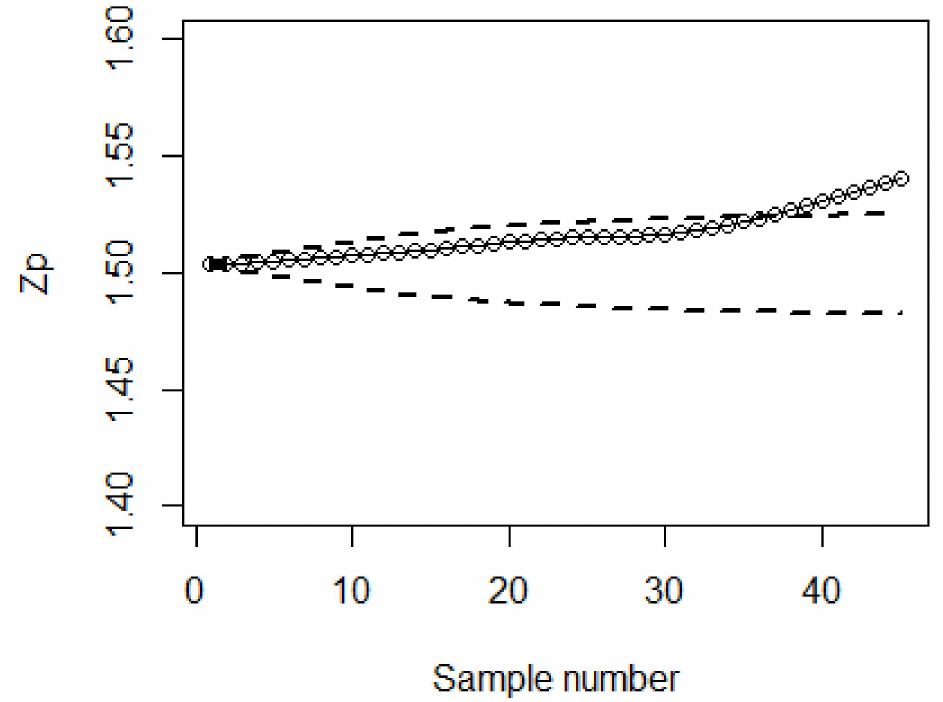
Figure 4. Bayesian HEWMA control chart using posterior and posterior predictive distribution under SELF for